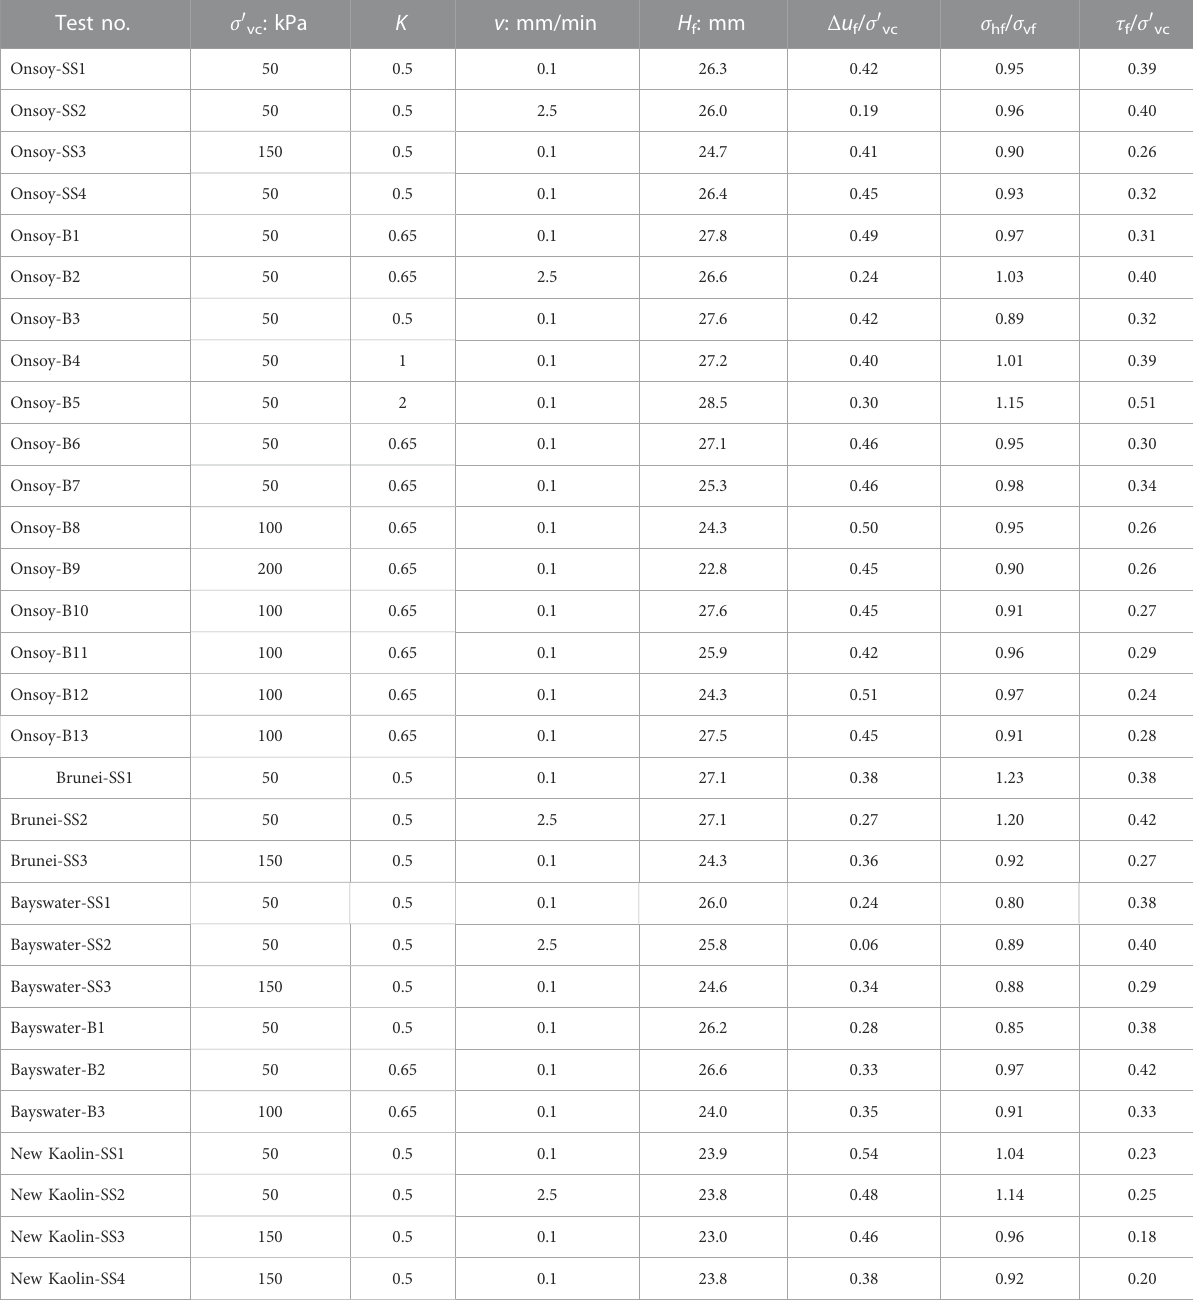
TABLE 3 Summary of test